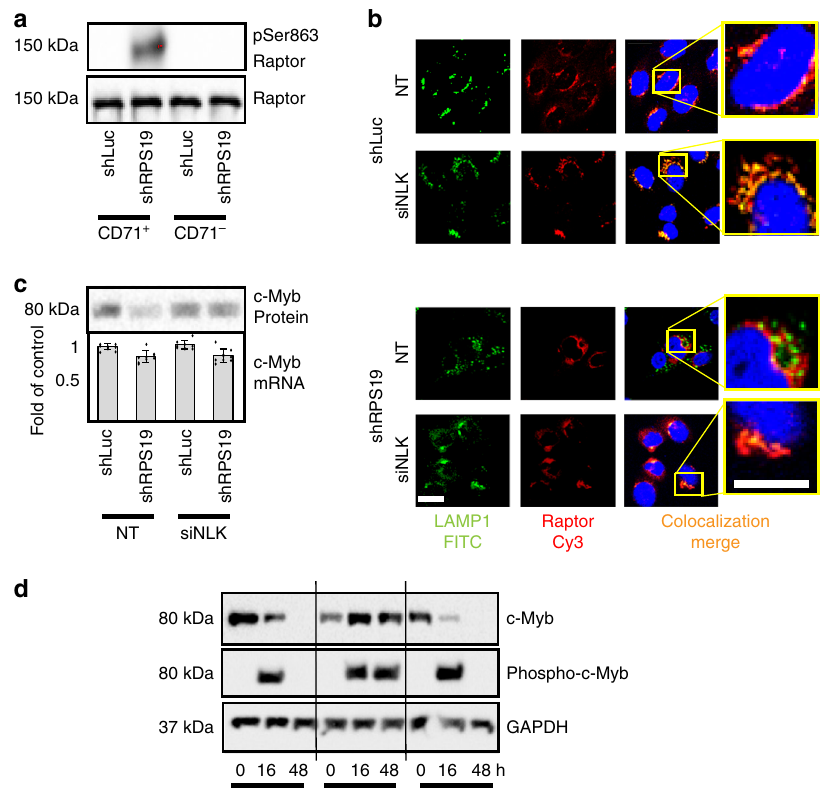
Fig. 7 NLK phosphorylation of c-Myb results in ubiquitination and proteasome degradation. a CD34 + CB HSPCs transduced with shRNA against control (shLuc) or RPS19 (shRPS19) were differentiated for 10 days and sorted into CD71 + and CD71 – fractions. Three independent experiments were pooled and populations were probed by Western blot analysis examining phospho-Ser863-Raptor and total Raptor. This experiment was performed in conjunction with Fig. 3c. b Cord blood CD34 + progenitors were transduced with shRNA against luciferase (shLuc) or RPS19 (shRPS19) and siRNA against NLK (siNLK) or a non-targeting (NT) sequence and differentiated for 8 days. Cells were fi xed, permeablized and incubated with Cy3-labeled antibody against Raptor (pseudo-colored red) and lysosomes were visualized by incubation with FITC-labeled antibody recognizing LAMP1 (pseudo-colored green). Areas of co- localization (merge) are indicated in yellow and yellow dotted boxes are magni fi ed in inserts to the far right. Scale bar, 15 µ m c Fetal liver CD34 + progenitors were transduced with shRNA against luciferase (shLuc) or RPS19 (shRPS19) in conjunction with siRNA against NLK (siNLK) or a non-targeting sequence (NT). Cells were differentiated for 5 days and split into two aliquots. One aliquot was lysed and probed for c-Myb protein expression by Western blot, while the second aliquot was subjected to qRT-PCR to examine c-Myb mRNA expression. d Kp53A1 cells were treated with vehicle alone, lactacystin or chloroquine for 30 min, prior to switching cells from 37 to 32 °C for the indicated times. Cells were lysed, normalized for protein and split into two. C-Myb was immunoprecipitated from one sample before Western blot analysis for phosphorylated serine, while the other sample was subjected to Western blot for c-Myb and GAPDH. Bars represent means± SD with individual data points overlaid. n = 3 independent experiments performed in triplicate. Also see Supplementary Fig. 7. Source data are provided as a Source Data fi